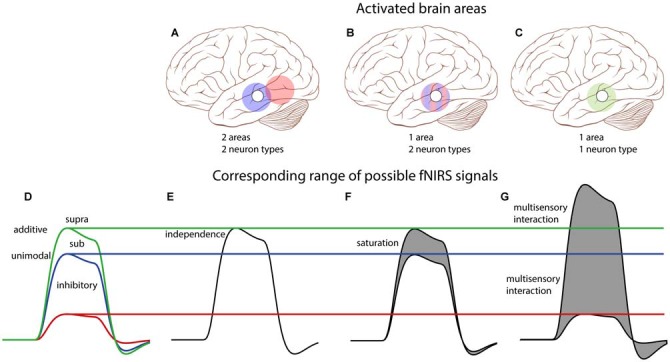
Conceptual schematic effects of potential audiovisual interactions on single-channel fNIRS signals. Top: We consider all three possible scenarios: (A) two spatially separated areas are each activated by either auditory or visual inputs; (B) neurons are either auditory or visually responsive, but are interspersed within one area; (C) one area contains bimodal neurons that respond to both auditory and visual stimulation. The open circle on the brain schematically depicts the location of the single T7/8 fNIRS channel, and colored circles depict the activation patterns of indicated areas: blue—auditory, red—visual, green—auditory and visual. Bottom: (D) Description of potential integrative effects (see also Figure 1). (E) For two independent areas of unisensory neurons (cf. A), the audiovisual fNIRS signal (black) can only be the sum of the auditory and visual fNIRS signals (and thus equals the additive model—green in D). (F) For a mix of unisensory neurons in one area (cf. B), both neuron populations will be similarly active for their unisensory-preferred stimulus as for the audiovisual stimulus. The fNIRS signal then equals the additive model, or less (gray area) if saturation of the BOLD response occurs (sub-additive model, between blue and green in D). (G) For an area with multisensory neurons (cf. C), fNIRS signals could yield any response type. Note that only a multisensory-area can generate multisensory interactions like super-additivity (above green), or inhibition (below blue). Parts of this image have been taken from https://commons.wikimedia.org/wiki/File:Skull_and_brain_normal_human.svg. Patrick J. Lynch; C. Carl Jaffe; Yale University Center for Advanced Instructional Media; under Creative Commons Attribution 2.5 License 2006.